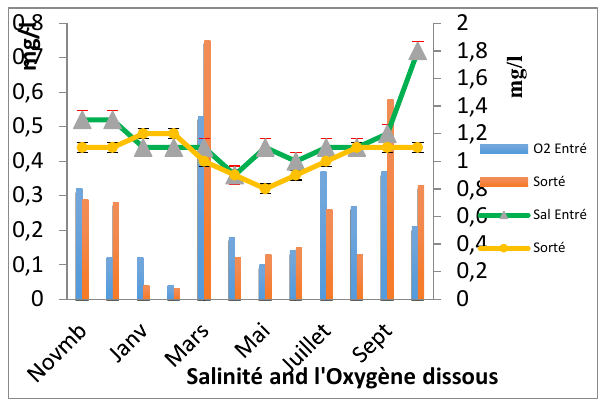
Figure 4. Variation in dissolved oxygen and salinity values